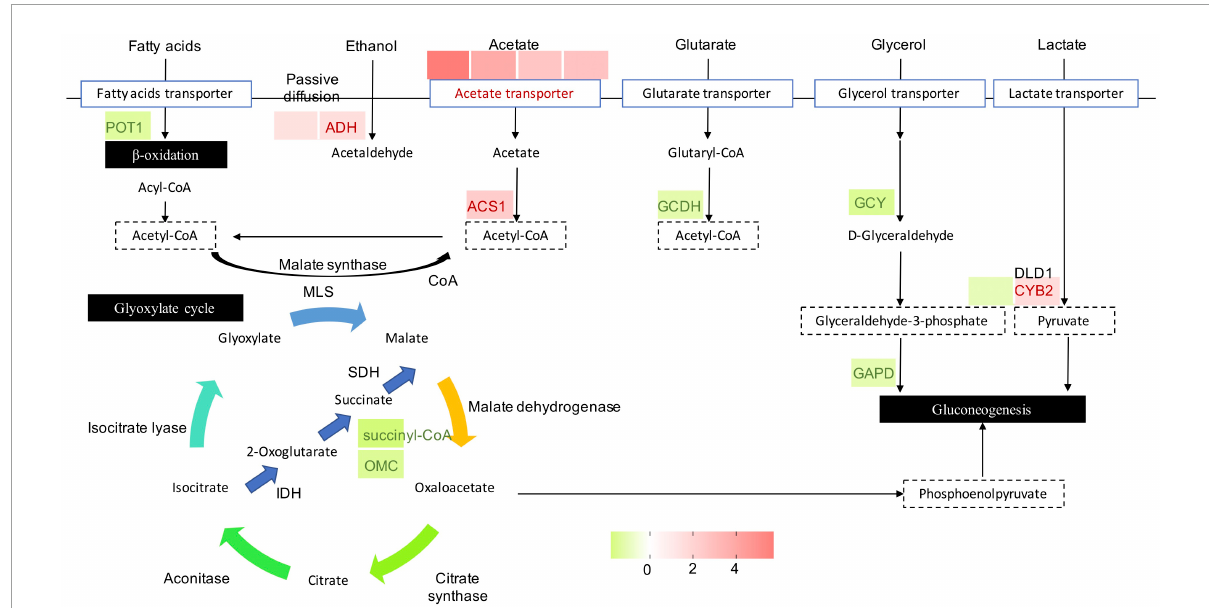
FIGURE8 Heat maps of differentially expressed genes (DEGs) that may be involved in alternative carbon metabolism. POT, 3-ketoacyl-CoA thiolase; ADH, alcohol dehydrogenase; ACS, acetyl-CoA synthetase; GCDH, glutaryl-CoA dehydrogenase; GCY, glycerol 2-dehydrogenase; GAPD, glyceraldehyde-3-phosphate dehydrogenase; DLD, dihydrolipoamide dehydrogenase; CYB2, cytochrome b2; OMC, 2-oxoglutarate-malate carrier; SDH, succinate dehydrogenase; MLS, malate synthase; IDH, isocitrate dehydrogenase. The expression image was generated using GraphPad Prism software: red, increase; green, decrease.